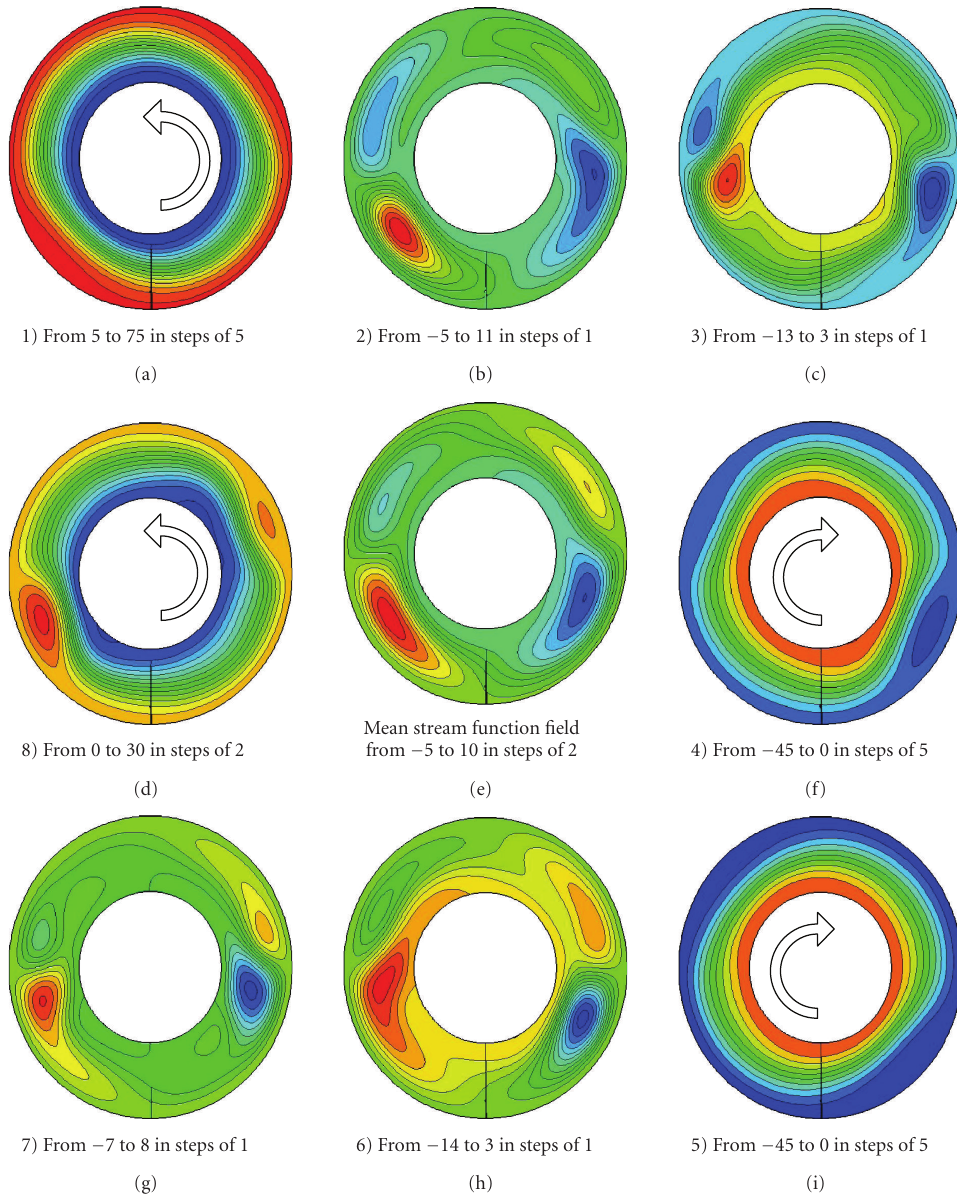
Figure 11: Equally spaced snapshots of the stream function; Ra = 15000, R = 2 . 0, and Pr =